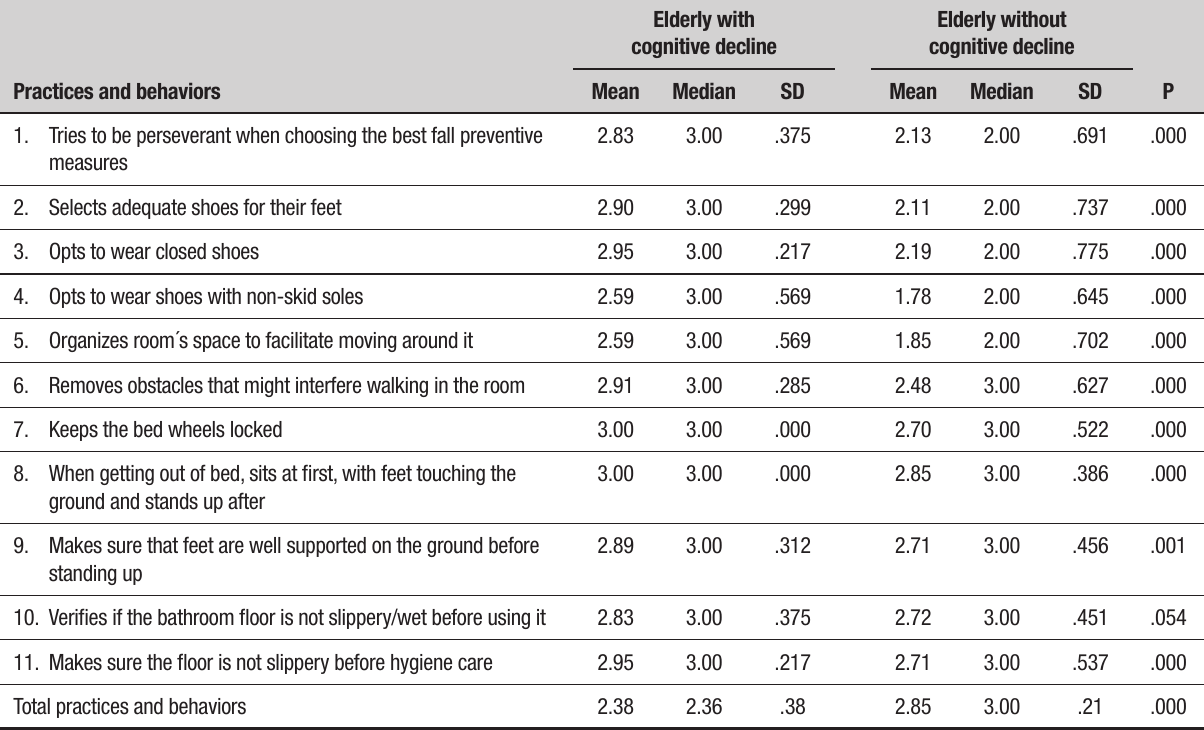
Total practices and